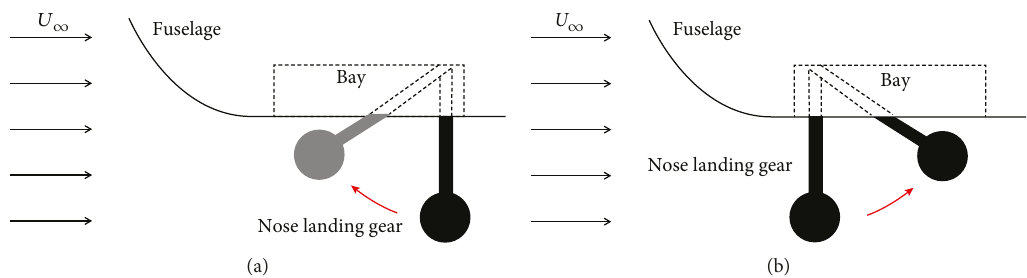
Figure 1: Schematic of the forward/rearward retraction of a nose landing gear: (a) forward retraction; (b) rearward